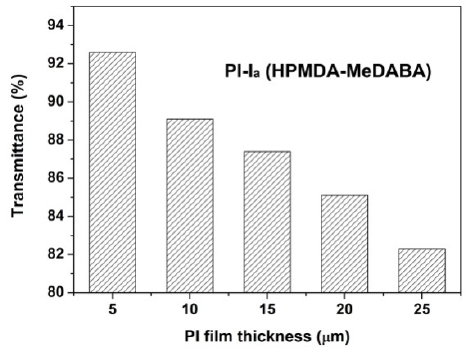
Figure 7. Thickness–transmittance relationship of PI-I a film.